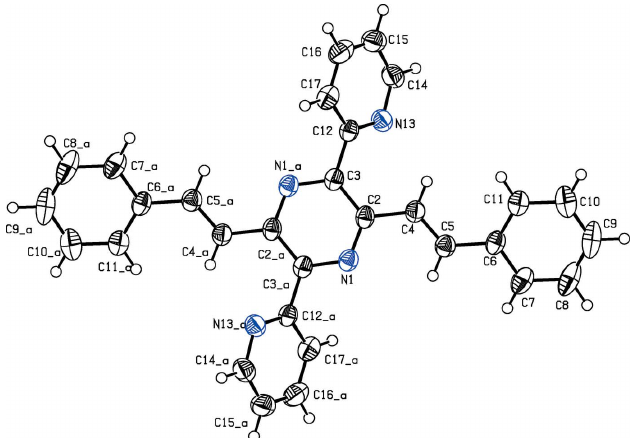
Figure 1 Perspective view of the title compound. Displacement ellipsoids are drawn at the 50% probability level. The second part of the molecule is generated by the symmetry operation 1 (cid:3) x , 1 (cid:3) y , 1 (cid:3) z .